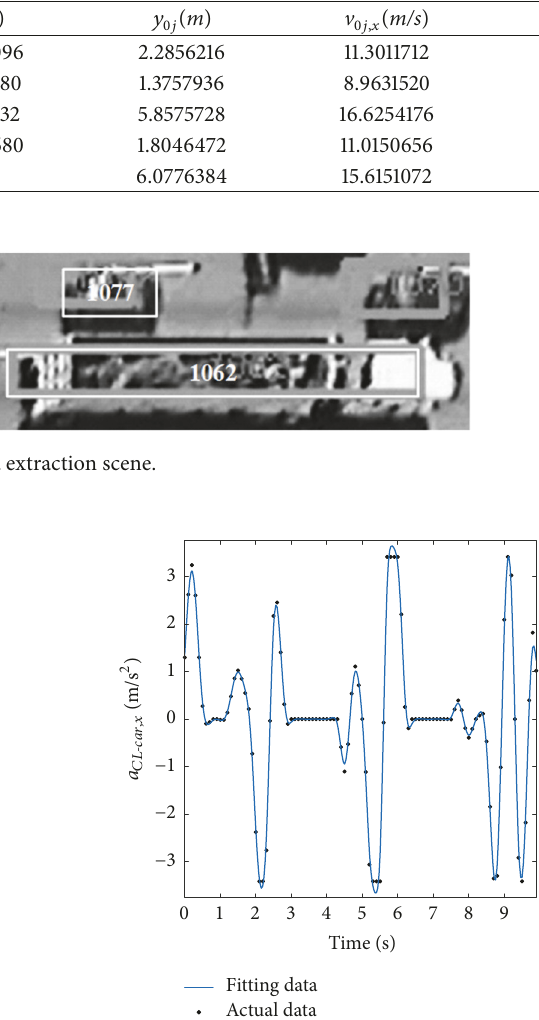
Figure 15: Acceleration curve of CL-car in the positive direction of X-axis with